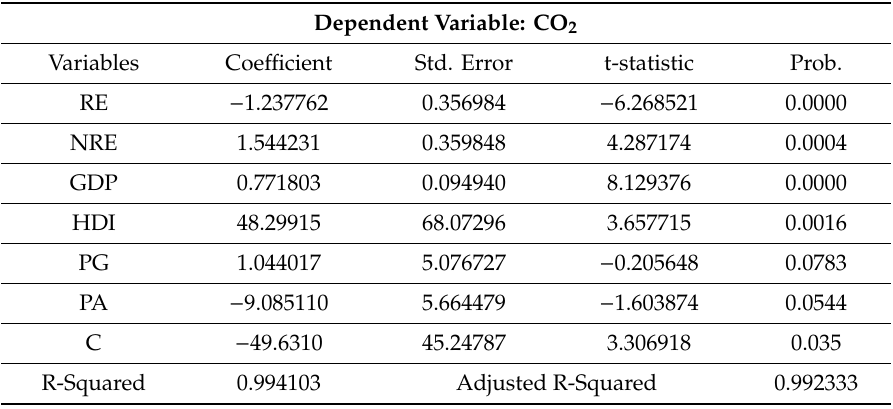
Table 3. Fully modified least squares (FMOLS).